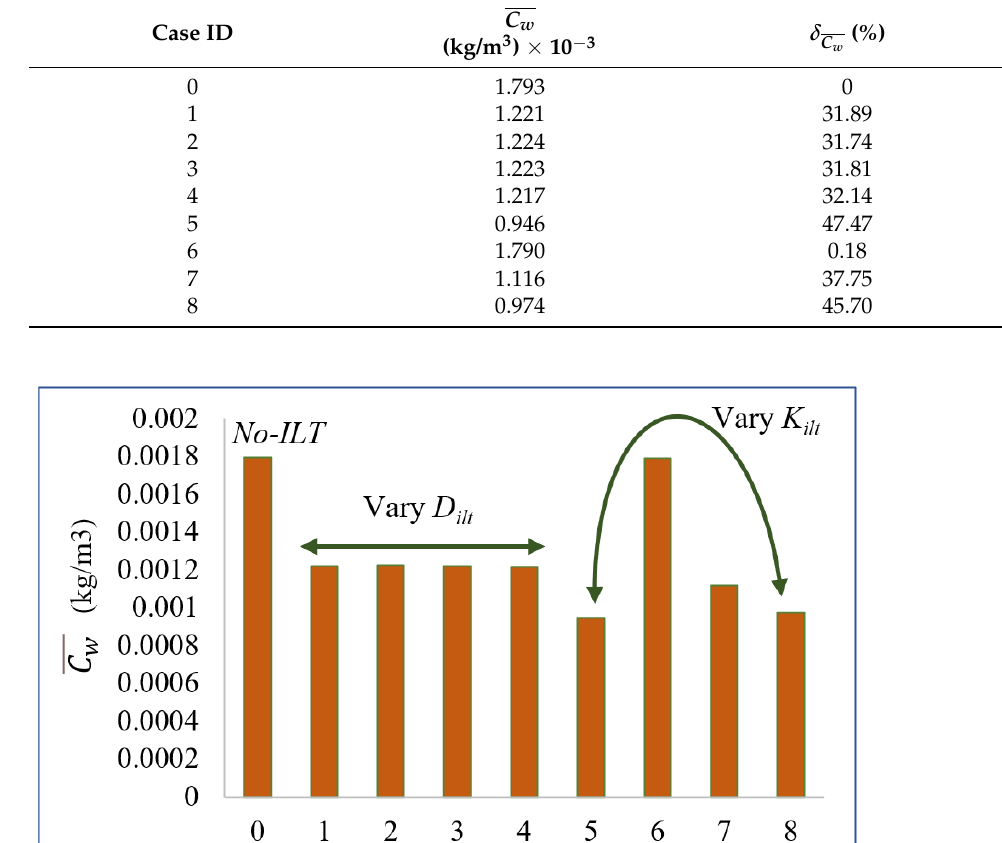
Table 3. Volumetric average of oxygen concentration in the arterial wall C w and percent difference of oxygen concentration in wall in reference to Case 0, computed using Equation (9).